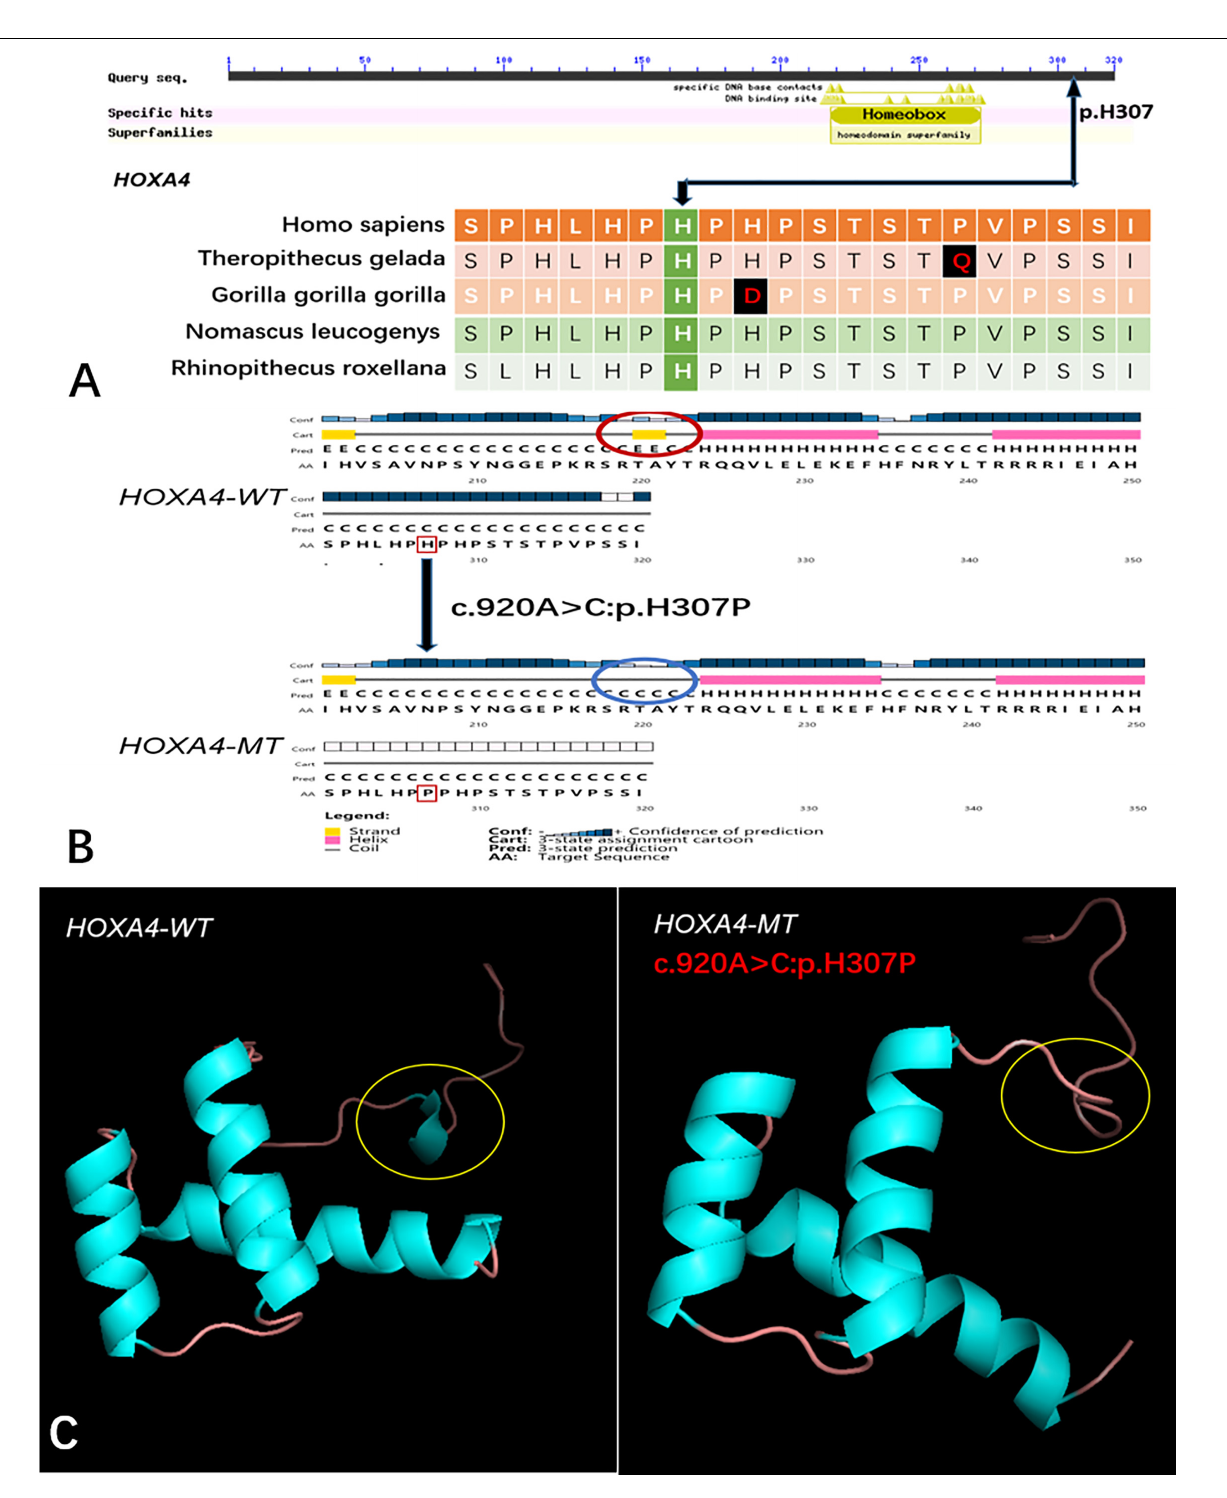
FIGURE 3 | Conservation of the HOXA4 mutation site across different species and wild-type and mutant secondary and crystal structures. (A) Amino acids affected by the HOXA4 c.920A > C:p.H307P mutation are highly conserved among different species; (B) The HOXA4 c.920A > C:p.H307P mutation identified in this study is predicted to modify the local secondary structure of the protein, circled in red and blue; (C) Template-based modeling of tertiary structures. Global view of the crystal structures of wild-type and mutant proteins demonstrating changes in protein structure attributable to the substitution. Local homology prediction demonstrating a high confidence rate (73.49%). WT, wild-type; MT,